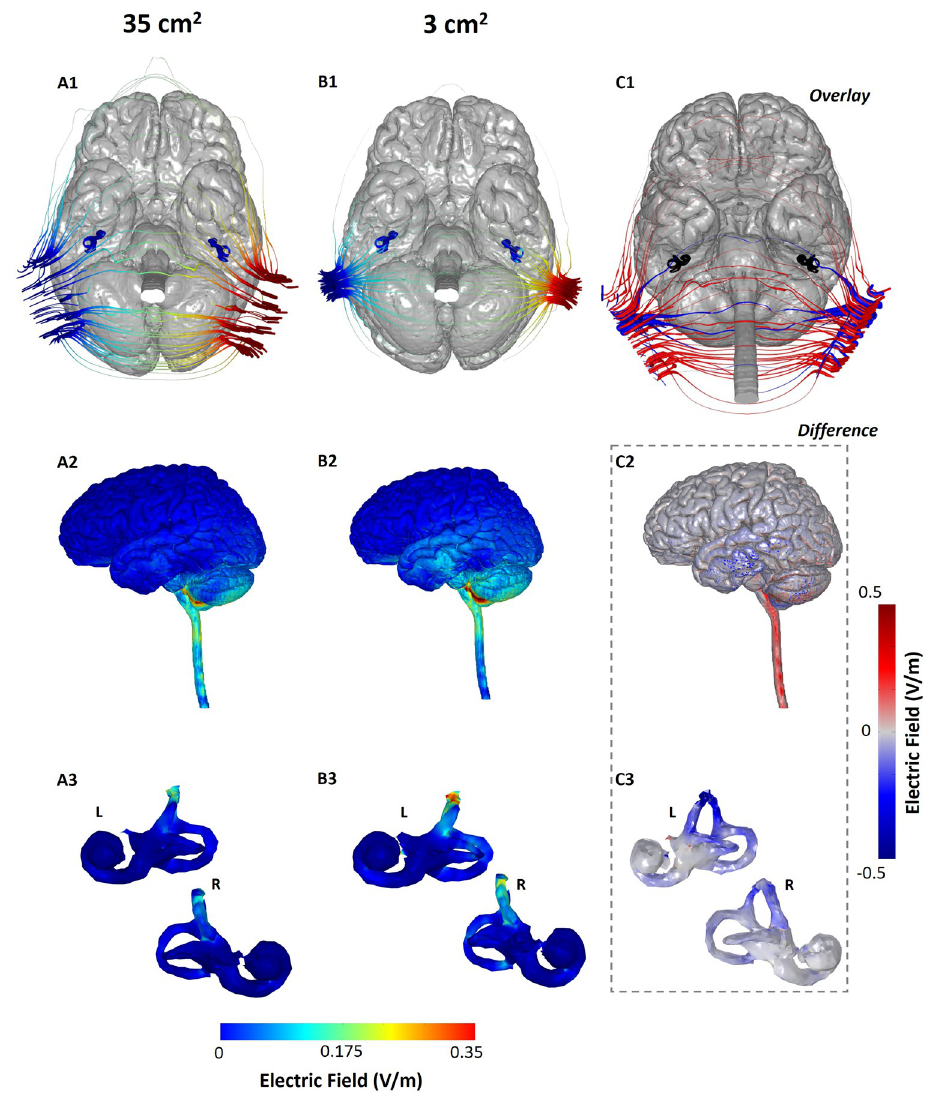
Fig 2. Comparison of GVS induced current flow using small- and large-size electrodes. Columns A (A1, A2, A3) and B (B1, B2, B3) correspond to the 35 cm 2 and 3 cm 2 electrodes, respectively. The current streamlines from both models are overlaid in C1. C2 and C3 indicate the difference in induced E-field due to the two electrode sizes. The first row (A1, B1 and C1) shows the current streamline plots with the brain, SCC and otolith organs masks visible to provide enhanced visualization of current flow with respect to their anatomy. The second row (A2, B2, and C2) shows the induced brain surface E-field plots. Similarly, the third row (A3, B3, and C3) shows the induced E-field plots on the vestibular